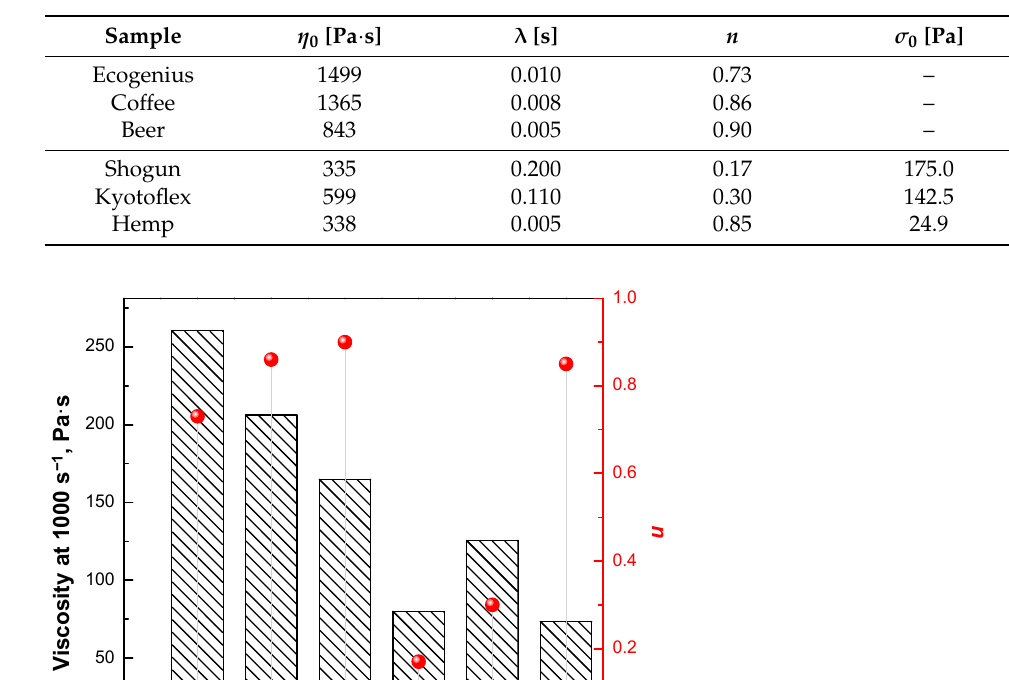
Table 2. Fitting parameters of complex viscosity curves using Carreau (Equation (1)) or Carreau modified (Equation (2)) models.